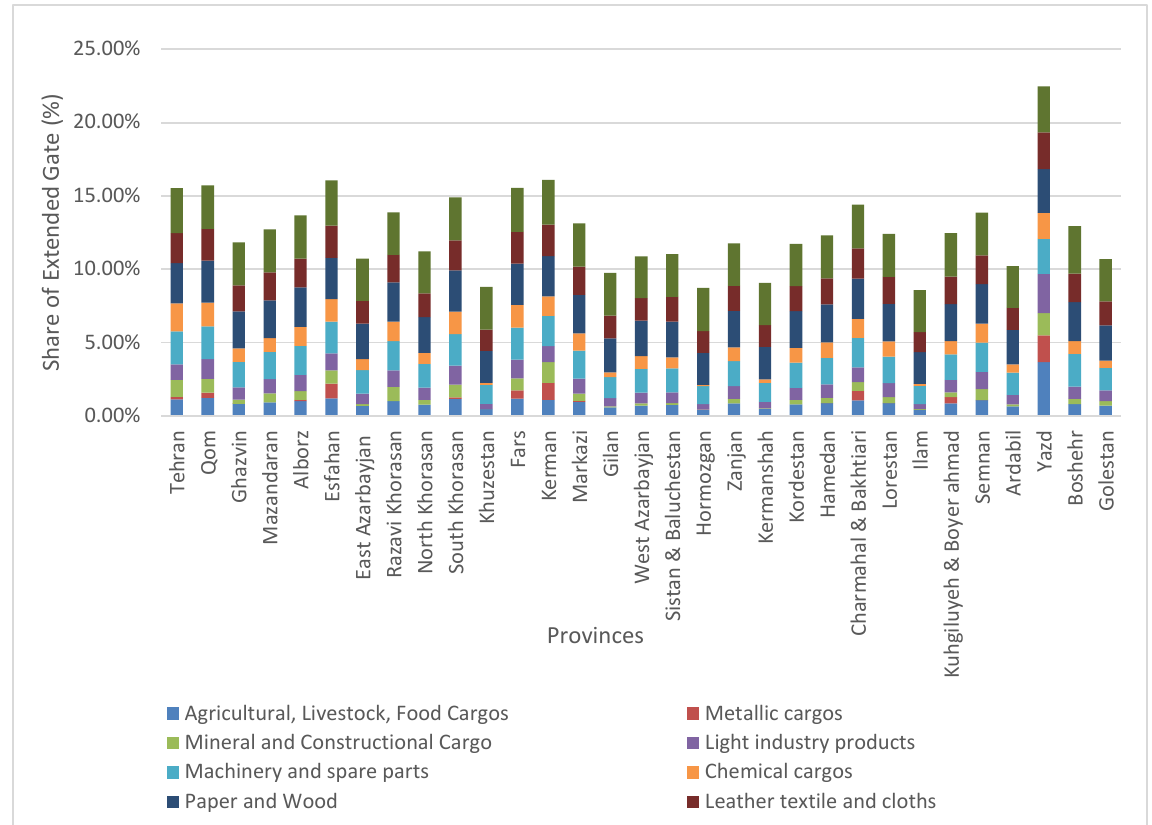
Figure 5. Share of extended gate from the total provincial imports and exports in 2015 (Ceteris Paribus) The average import/export redirection for each province to the extended gate was calculated to be 12.68%, with a maximum of 22.5% for Yazd and a minimum of 8.59% for Ilam province, while for the capital, Tehran, it was